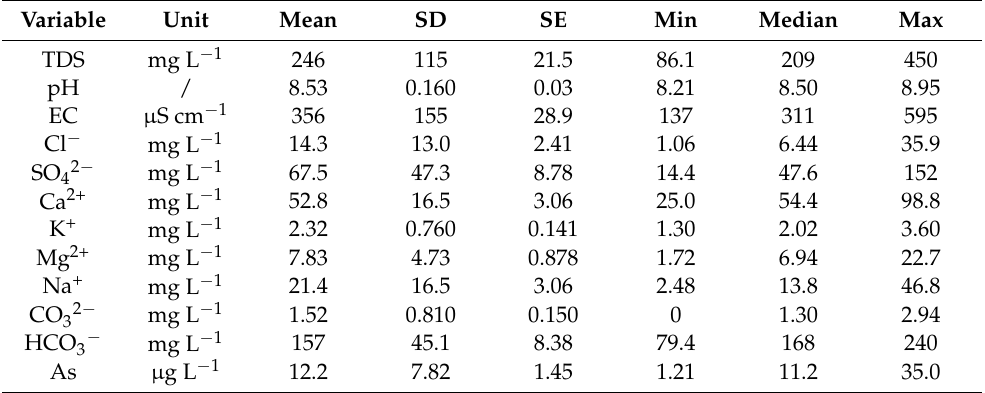
Table 1. Descriptive statistical analysis of river-water-chemistry variables in Tianshan Mts. area ( n = 29). Parameters include: mean value, standard deviation (SD), standard error of mean (SE), minimum (Min), median, and maximum (Max)